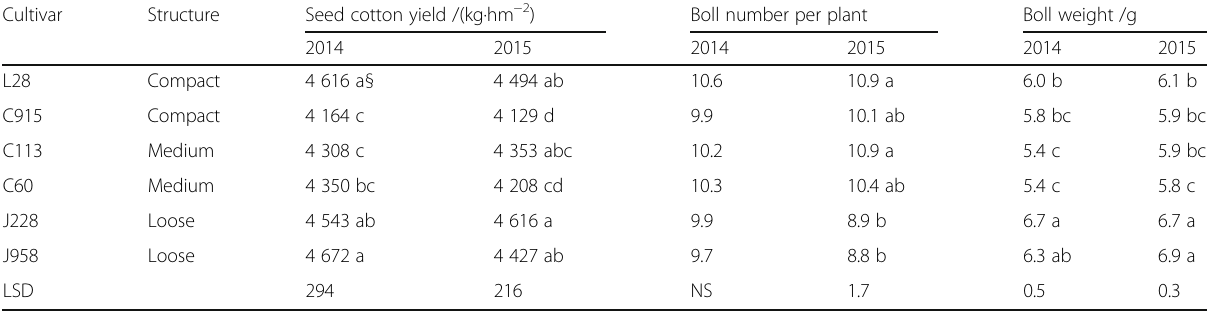
Table 1 Varietal effects on cotton yield and yield components in 2014 and 2015